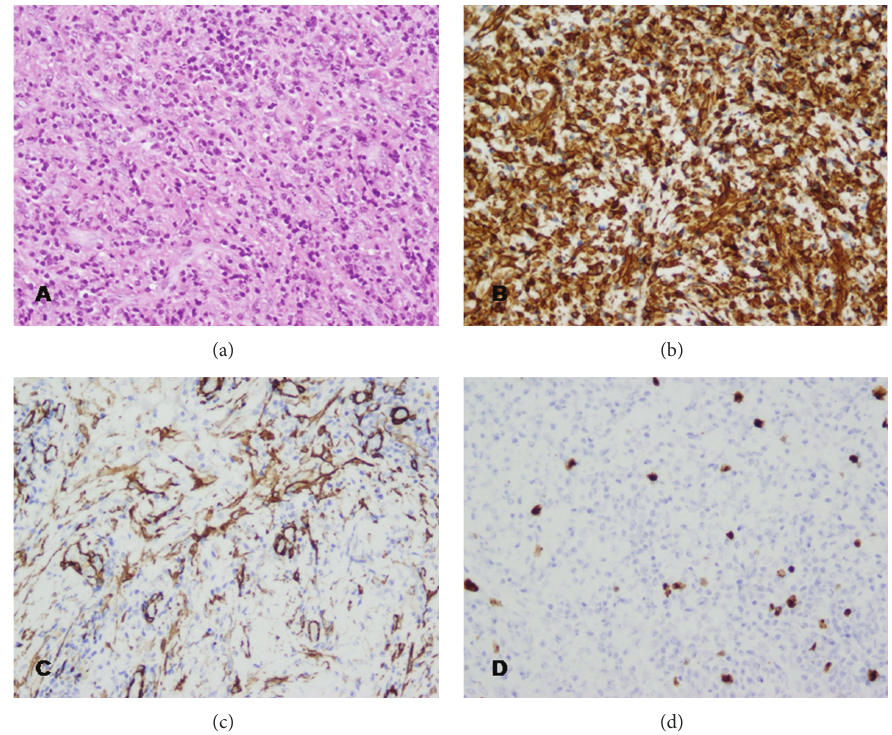
Figure 3: Histological and immunohistochemical examination of the maxillary mass. (a) Hematoxylin-eosin staining demonstrating spindle cells sprinkled with inflammatory cells, with a predominance of plasma cells and lymphocytes (original magnification ×200 ). (b) immunohistochemical staining showing strong reactivity for vimentin (original magnification ×200 ). (c) Immunohistochemical staining showing moderate reactivity for 𝛼 -smooth muscle actin (original magnification ×200 ). (d) Immunohistochemical staining showing focal and weak immunoreactivity of the tumor cells for Ki-67 (original magnification ×200 ).